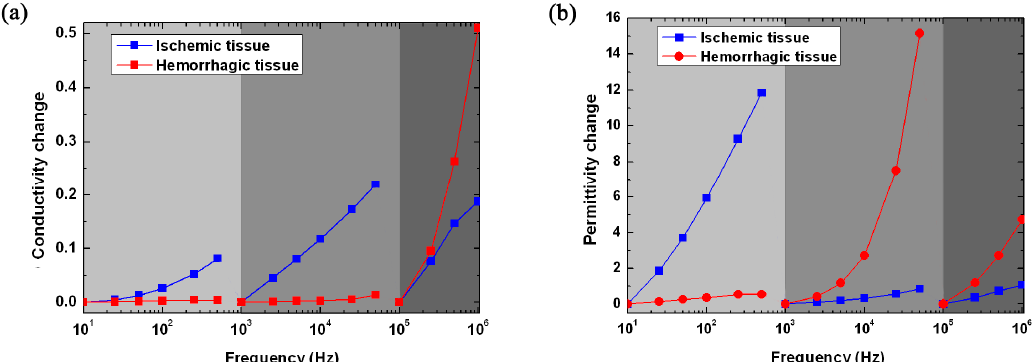
Figure 6. Ratio of change in conductivity ( a ) and permittivity ( b ) of ischemic and hemorrhagic tissue with regard to the low-frequency (10 Hz–1 kHz; 10 Hz is the reference frequency), middle-frequency (1 kHz–100 kHz; 1 kHz is the reference frequency) and high-frequency (100 kHz–1 MHz; 100 kHz is the reference frequency) ranges.